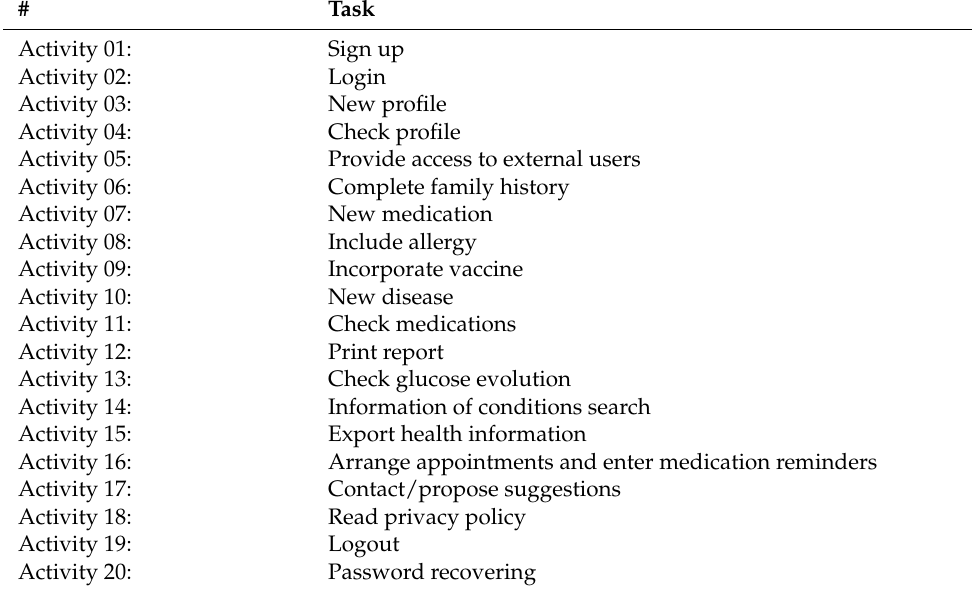
Table 2. Typical activities to be done in a